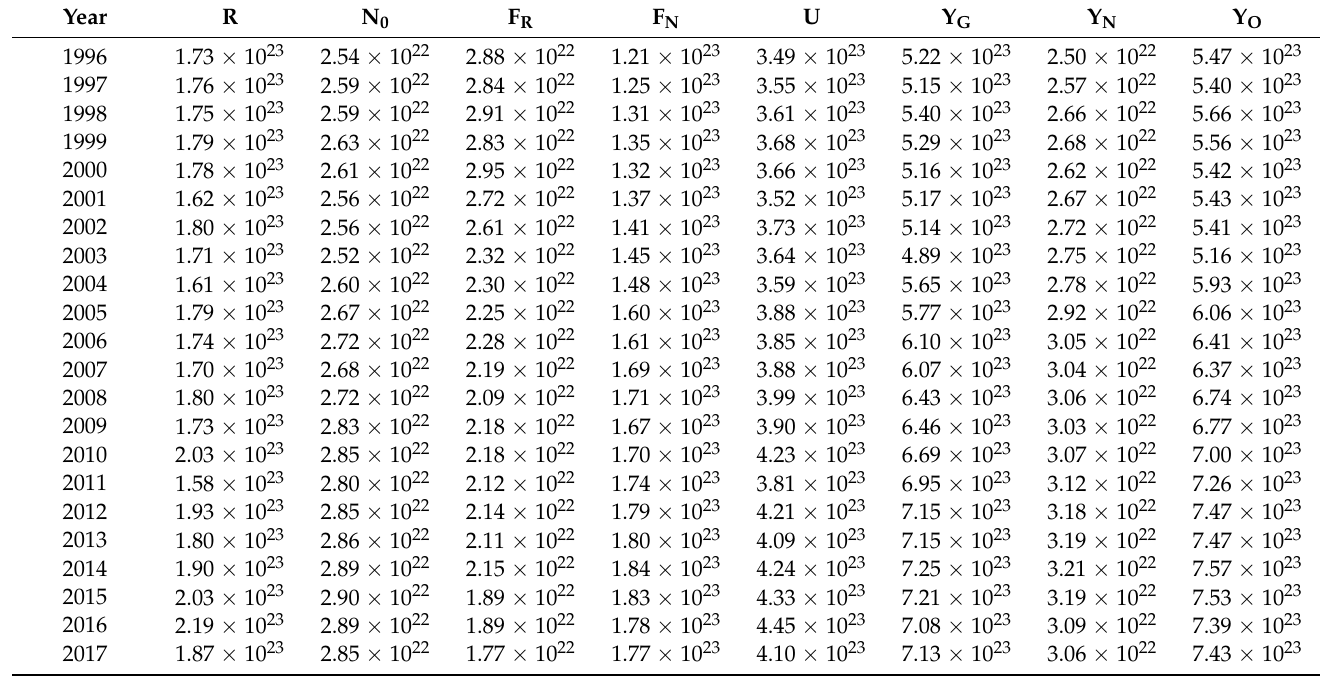
Table 4. Results of accounting for agroeconomic ecosystem emergy in China, 1996–2017. (Unit: sej).